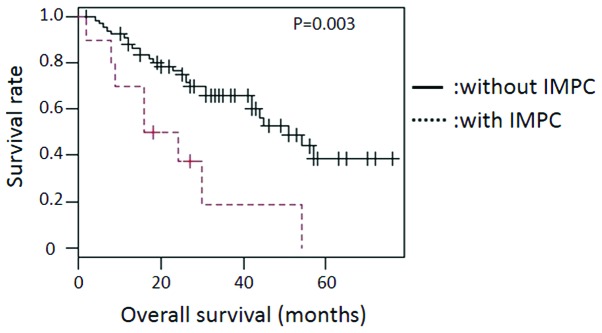
OS rate of patients with IMPC component. Patients with IMPC component showed reduced OS (P=0.003). OS, overall survival; IMPC, invasive micropapillary carcinoma.